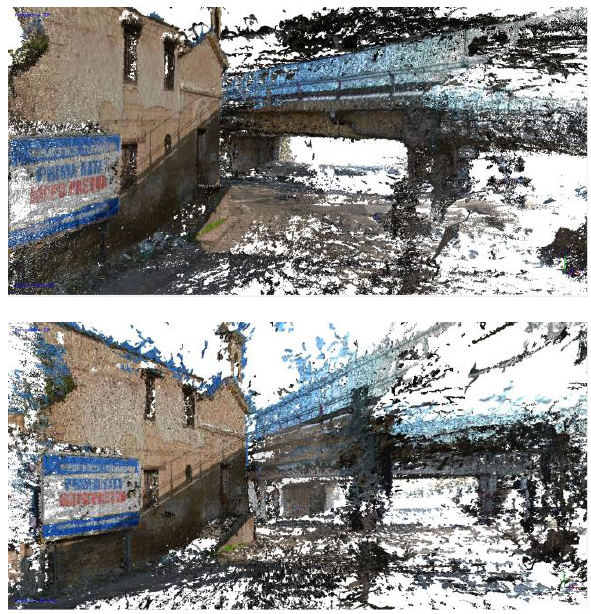
Figure 7 . Detail of the point cloud obtained in Metashape without masks (top) and with masks for the sky (bottom).